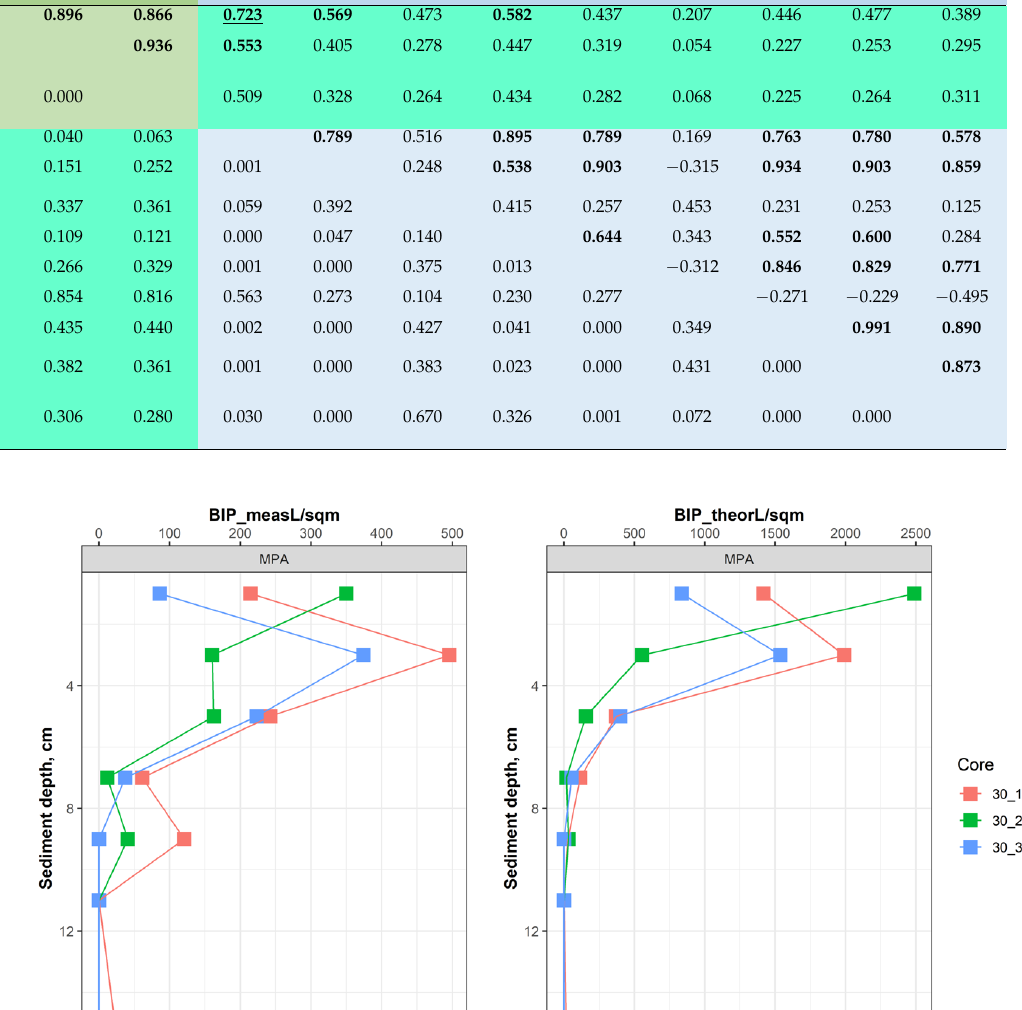
Figure 5. Three exemplary vertical profiles of BIPc estimated based on measured ( left ) and “theo- retical” ( right ) burrow depths of macrofauna organisms. Take a note of the different scales used in the graphs.